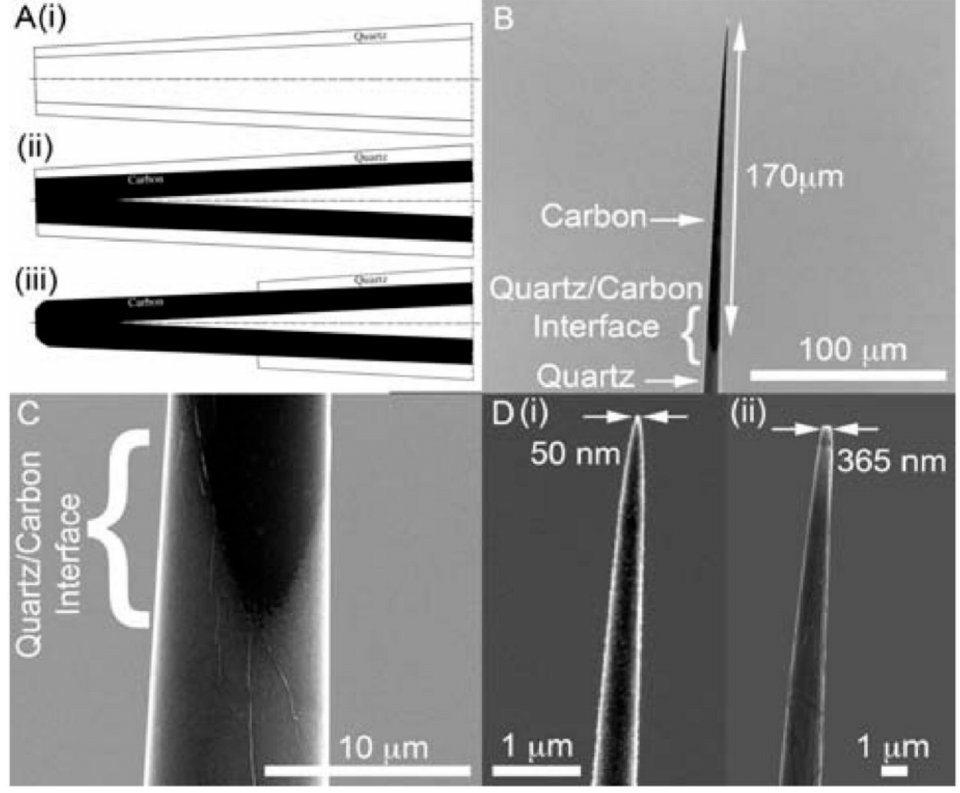
Figure 3. The carbon nanopipette electrode (CNPE) developed by Rees et al. Reprinted with permission from